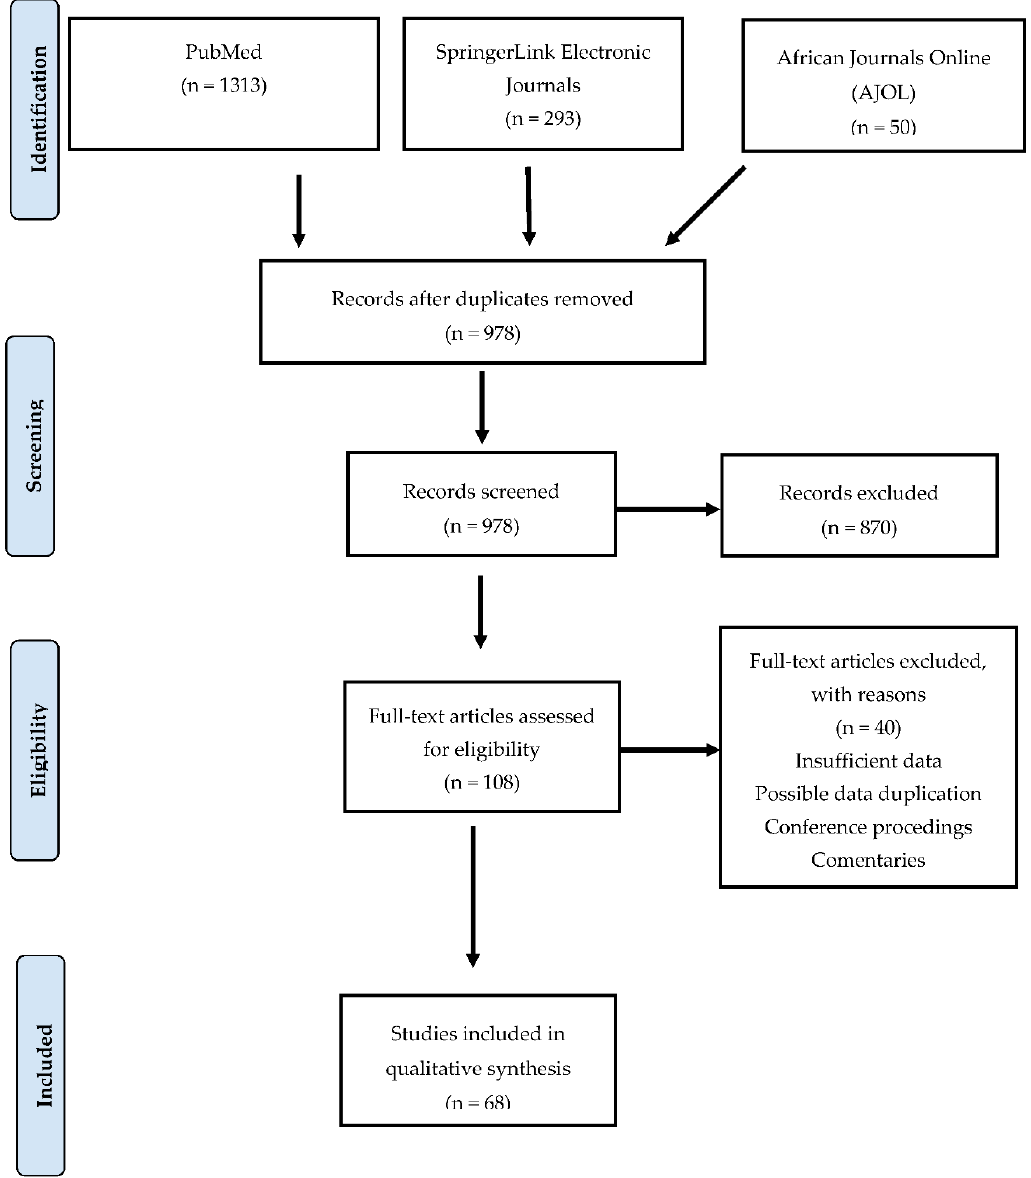
Figure 1. Preferred Reporting Items for Systematic Reviews and Meta-Analyses (PRISMA) flow chart of the literature search, screening, assessing eligibility and article